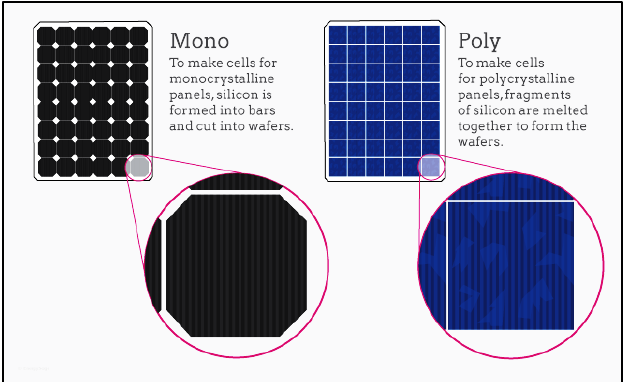
Figure 6: Monocrysttaline and polycrysttaline solar panel